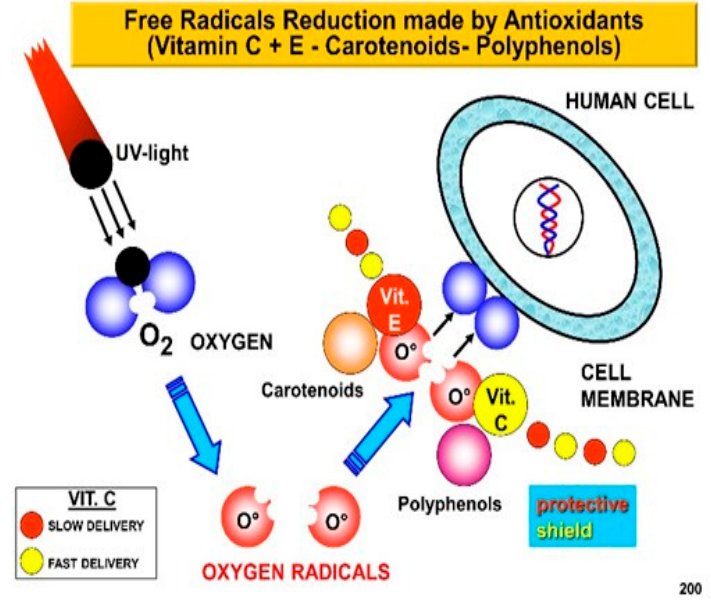
Figure 5. Free radical activity and antioxidants effectiveness at cell level.